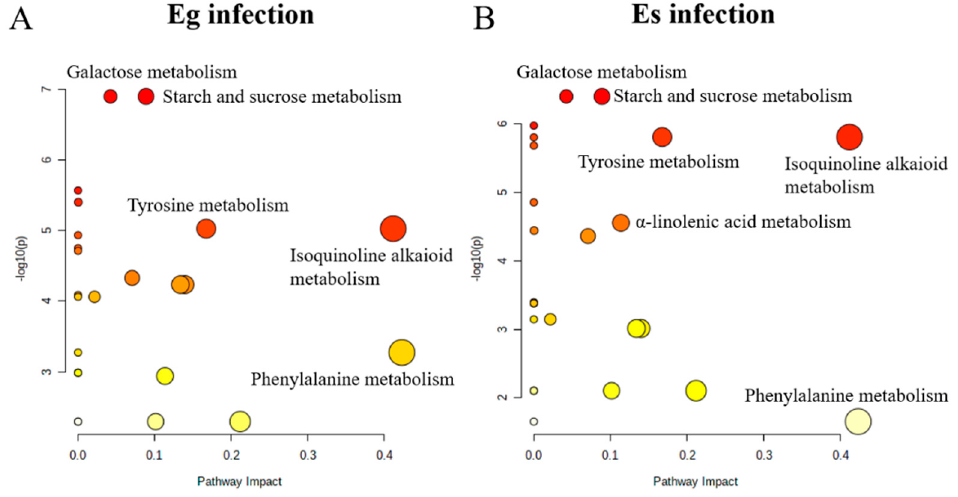
Figure 6. KEGG pathway analysis of the effect of ( A ) Eg infection and ( B ) Es infection on the